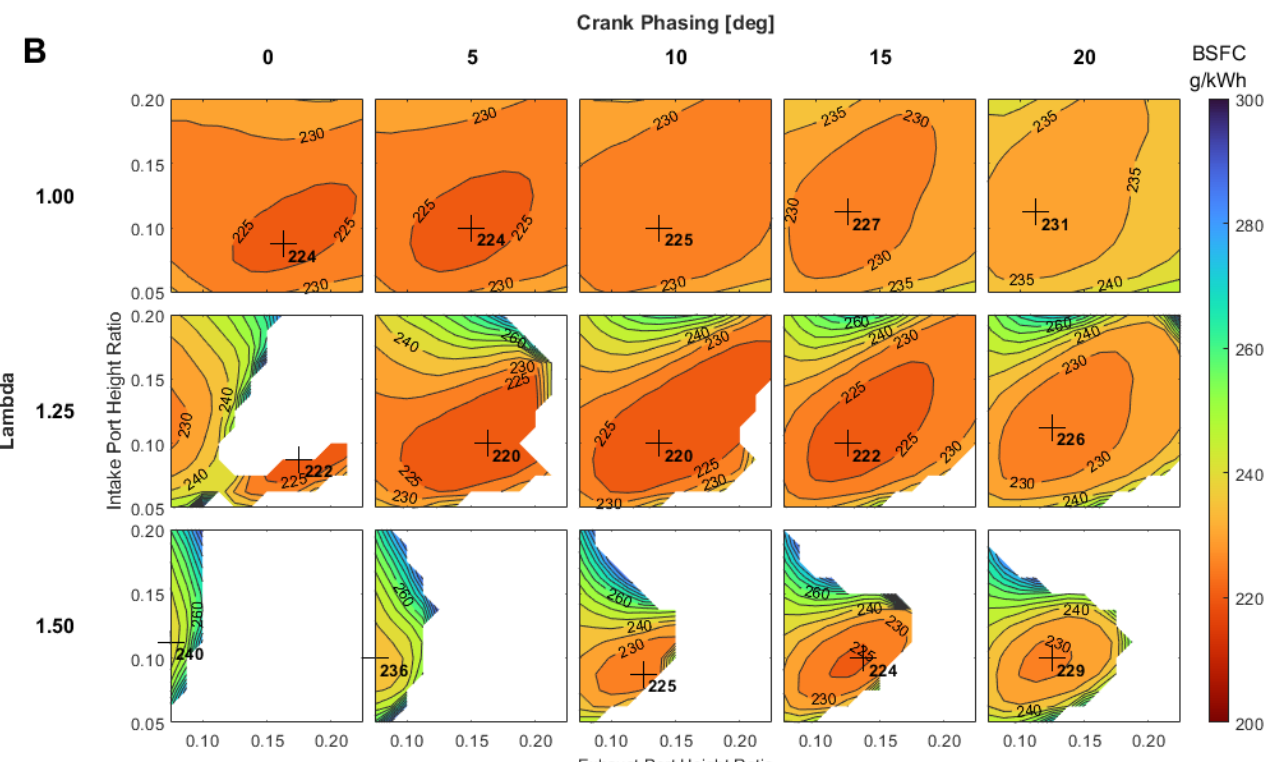
Figure 12. Variation in BSFC with crankshaft phasing and intake and exhaust port height-to-stroke ratio at operating point B (1500 min − 1 , 12-bar BMEP), for air-to-fuel equivalence ratios λ = 1–1.5. White space indicates inoperable regions. All BSFC contours are drawn at intervals of 5 g/kWh.